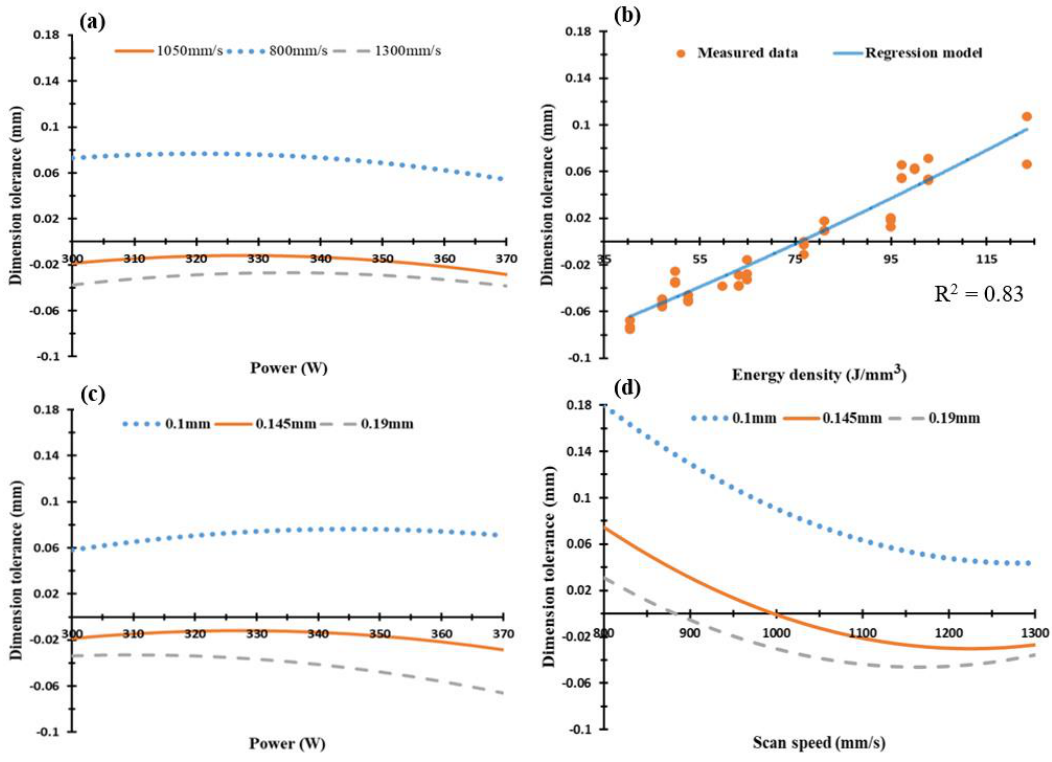
Figure 16. Dimension tolerance of the as-built Al6061 samples vs. ( a ) laser power (W), ( b ) energy density (J/mm 3 ), ( c ) hatch spacing (mm), and ( d ) scan speed